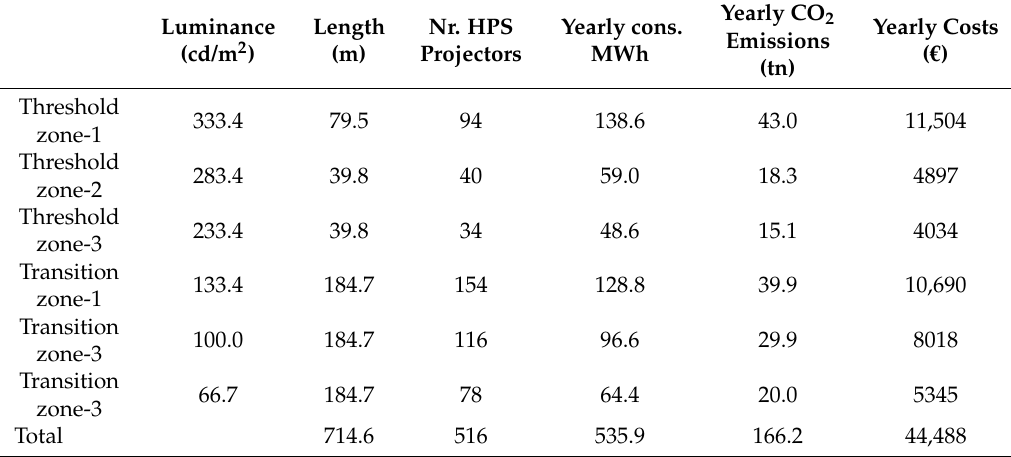
Table 3. Main parameters of lighting installation before implementation of any action to increase its